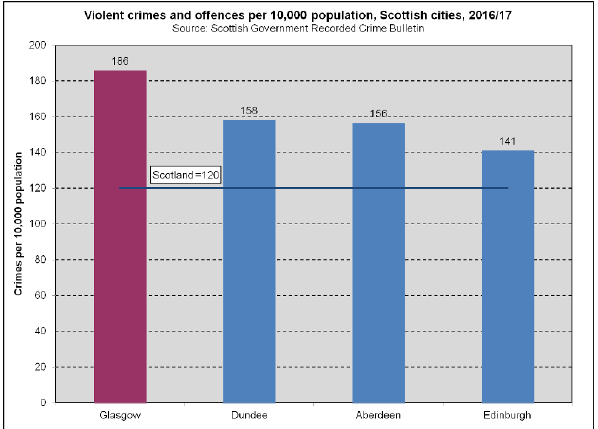
Figure 1. Violent crime and offences in Scottish Cities 2016/17. 65